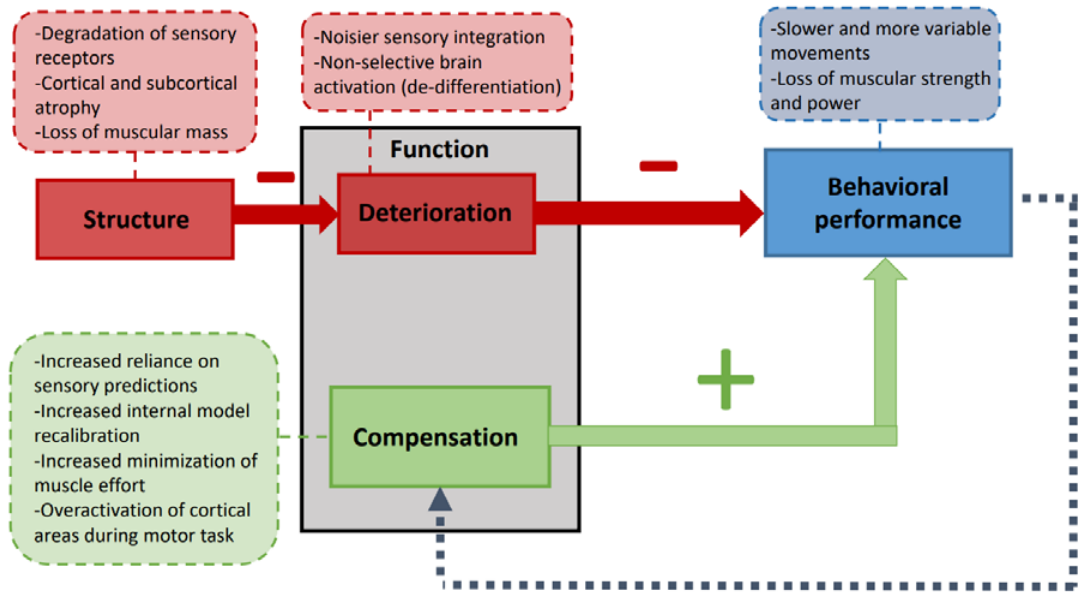
Figure 1. A model of deterioration and compensation of the motor function with aging. Adapted from Papegaaij et al. (2014). Aging alters the structure of the sensorimotor system, causing functional deteriorations (i.e., deterioration in how these structures act during motor tasks) and decreased behavioral motor performances. Decreased performance triggers the need for functional compensations (modifications in how brain structures act to attain motor goals) to maintain behavioral performance. Dashed boxes provide examples of deteriorated and compensating modifications. Examples of age-related structure alterations: degradation of sensory receptors [48–50], cortical atrophy [51–53], and loss of muscular mass [54]. Examples of functional deterioration: noisier sensory integration [48,50] and nonselective brain activation [17,23]. Examples of behavioral modifications: slower and more variable movements [46,47] and loss of muscular strength and power [45,54]. Examples of functional compensations: increased reliance on sensory predictions [55–57], increased internal model recalibration [58], increased minimization of muscle effort [59], and overactivation of cortical areas during motor tasks